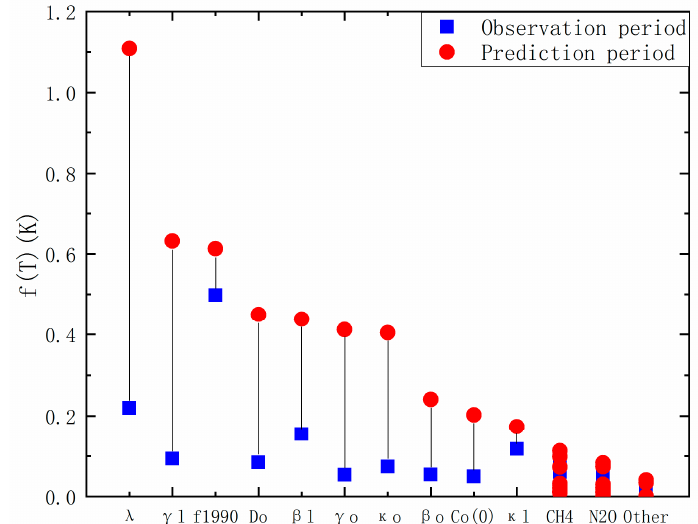
Figure 2. Maximum objective function values of all parameters in the observation period and prediction period.